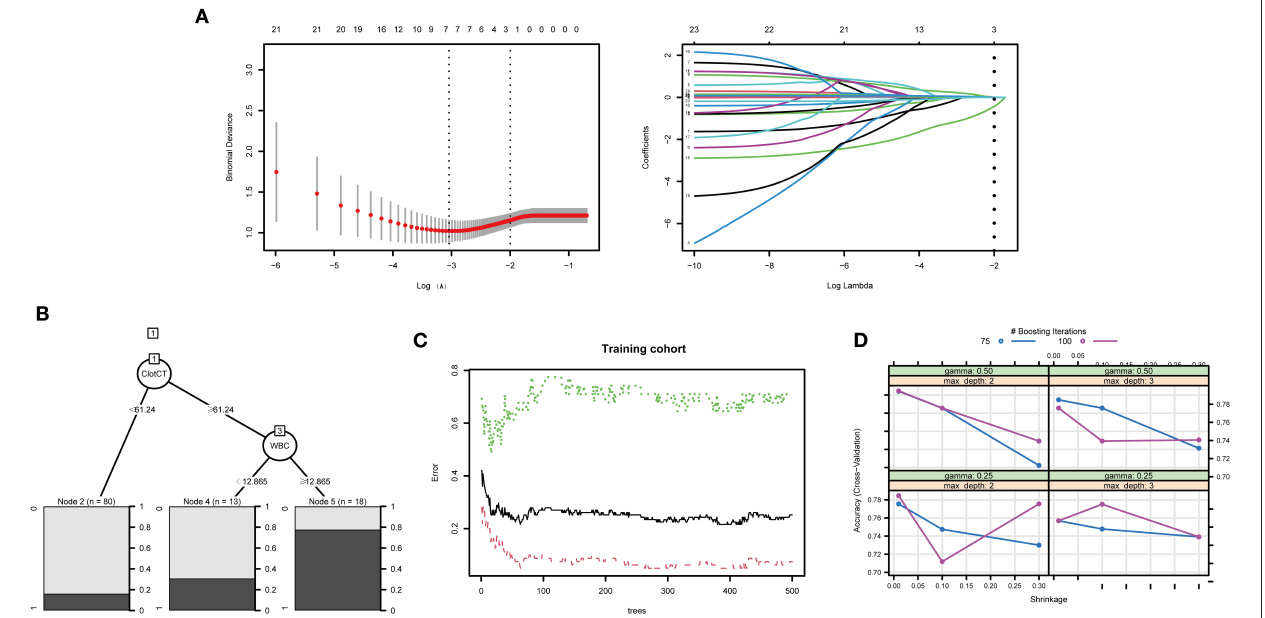
FIGURE 2 | The training process and optimal parameters of the LASSO and tree ML models were demonstrated. (A) Demonstrates that 23 features finally decreased to two features when using an optimal λ of 0.1356784 and log( λ ) of − 1.997 parameters. (B) Shows that the optimal decision nodes were CT value of subarachnoid clot and WBC count during the training process of DT. The minimum error was obtained when the optima tree number was 63, the training process of RF is shown in (C) . (D) Displays the training process of XGBoost, and we can obtain the best prediction power when gamma of 0.25, maximum depth of 2, and nrounds value of 100.